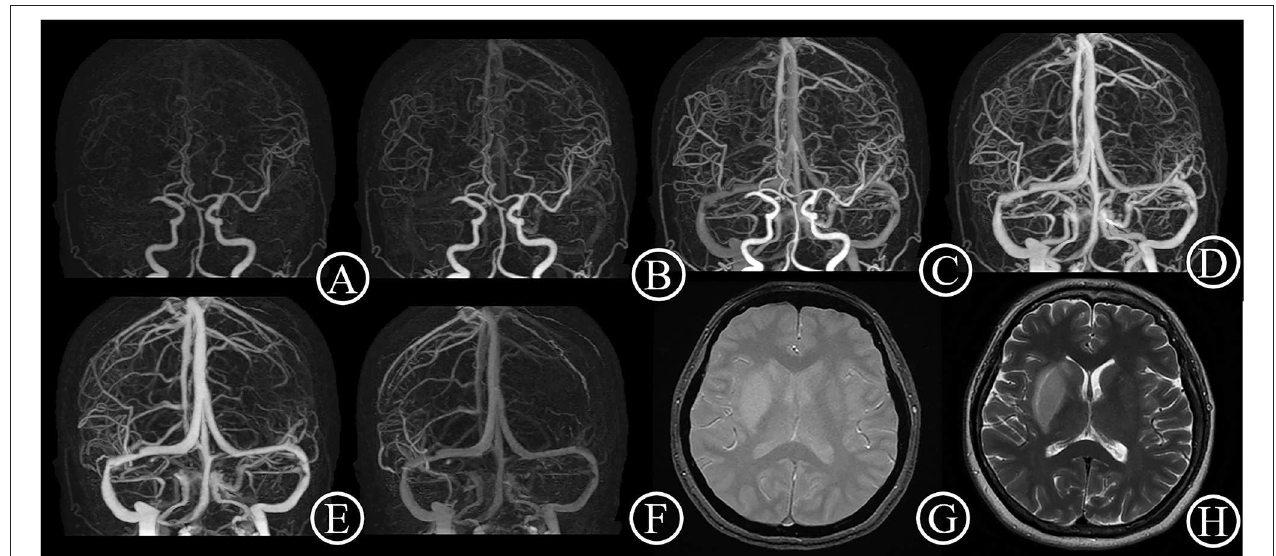
FIGURE 1 | Good collateral case. One 48-year-old female patient suddenly suffered from inability to lift left upper limb for 30min. She had an initial NIHSS score of 11 and a mRS score of 0 after 3 months. 4D CTA (A–F) showed occlusion of right middle cerebral artery, and complete collateral circulation before venous phase. Thus, the patient got a 4D CTA collateral circulation score of 4. The T2 star (G) and T2WI (H) on day 6 showed a small acute infarct lesion without hemorrhage transformation.